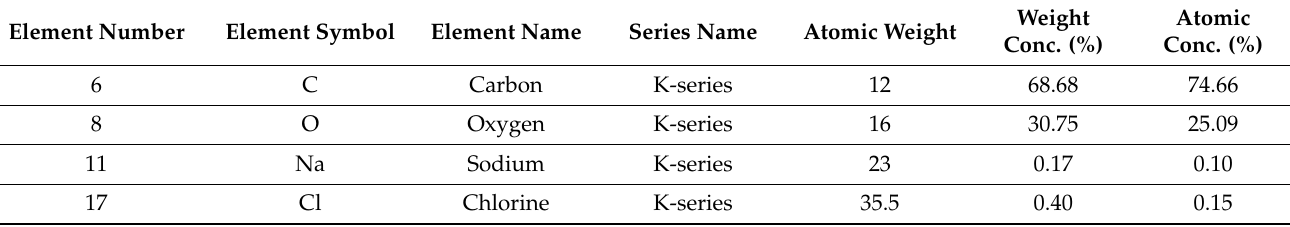
Table 6. Chemical structure of single sisal fiber hybrid composite at surface